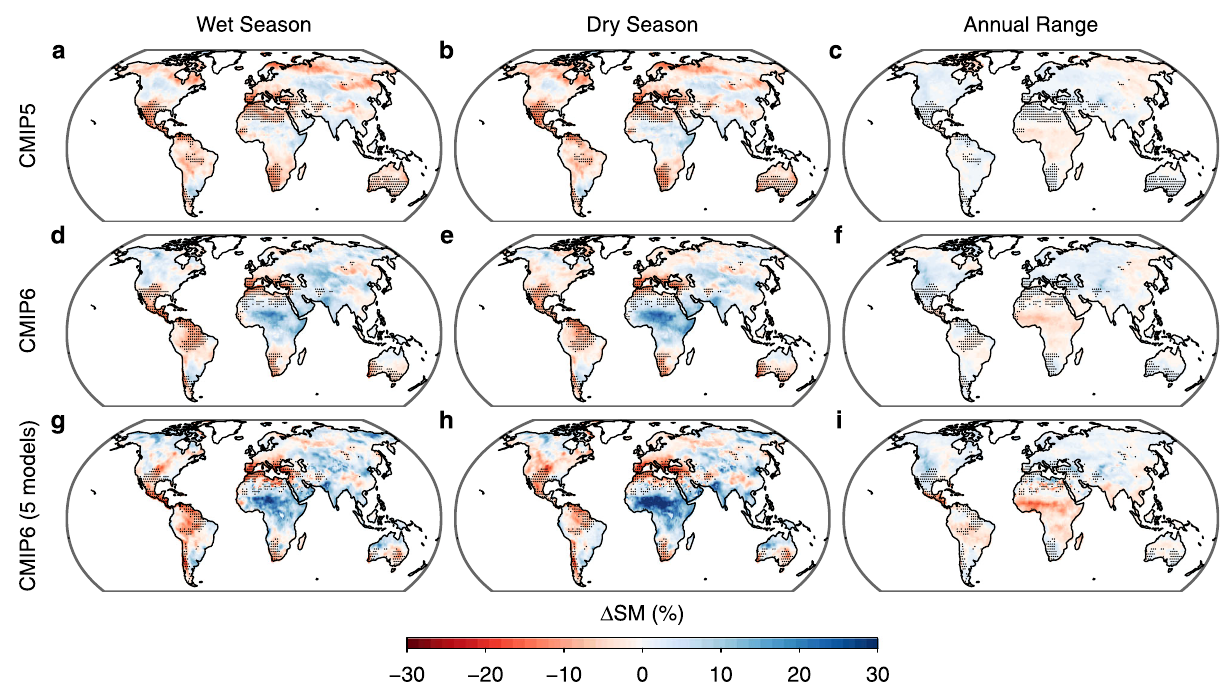
Fig. 2 | Multi-model mean seasonal changes in soil moisture in CMIP5 and CMIP6. Thepercentchangeinsoilmoisture( Δ SM)isassessedbetween1971 – 2000 (historical simulation) and 2071 – 2100 (RCP8.5 or SSP585 simulation) in 35 CMIP5 models ( a – c ) and 30 CMIP6 models ( d – f ), and between 1980 – 2000 (historical